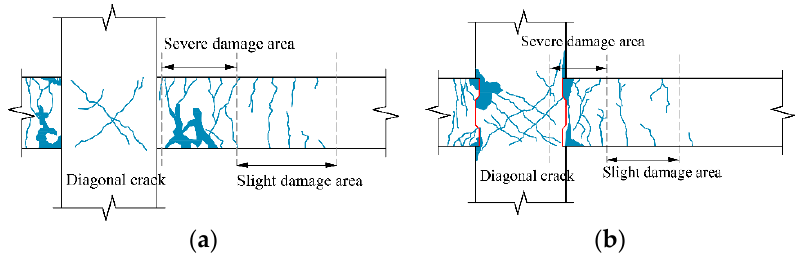
Figure 6. Comparison of crack distribution: ( a ) RC joint; ( b ) monolithic precast joint.